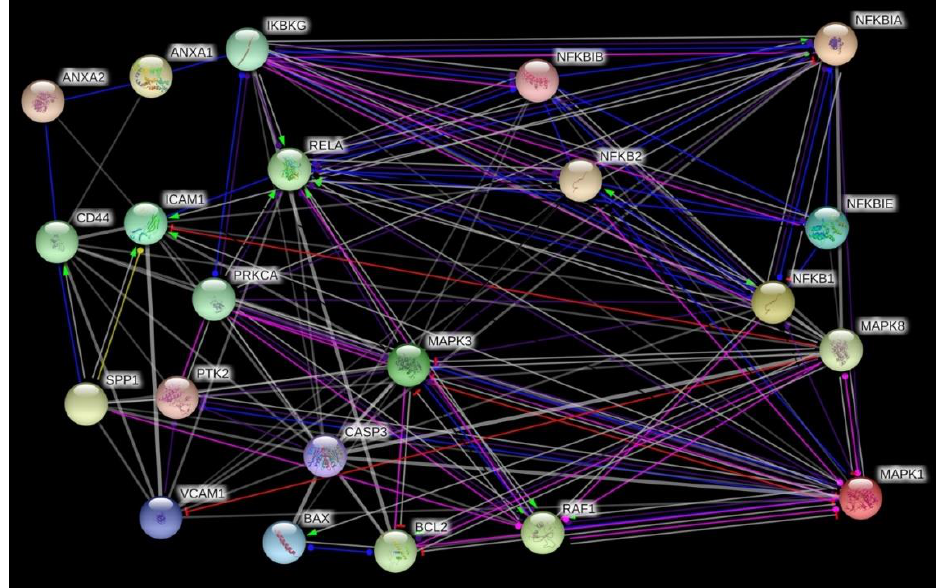
Figure 9. Network of the functional interaction of genes and their products analyzed in this study. The analysis was performed by STRING (Search Tool for the Retrieval of Interacting Genes/Proteins) v11.0) provided by the STRING Consortium (Available online: https://string-db.org/). The result is presented in the molecule action mode. Gene names are indicated.